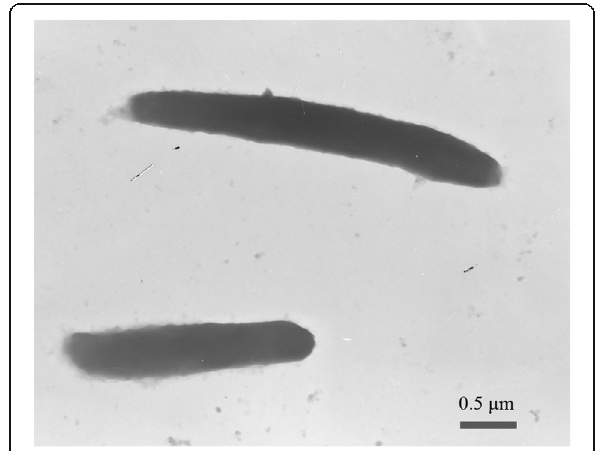
Fig. 1 Transmission electron micrographs of Arcticibacterium luteifluviistationis SM1504 T cultured on TYS broth medium. Scale bar, 0.5 μ m